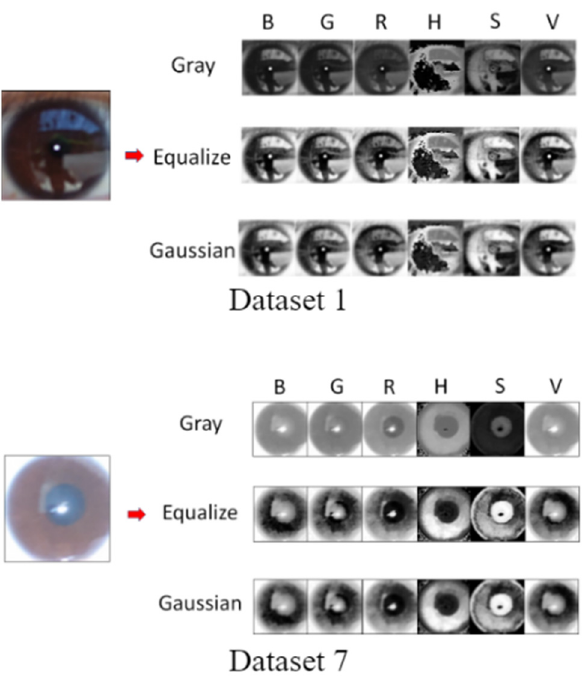
Figure 51. Iris color range obtained after each processing stage for Data Sets 1 and 7.